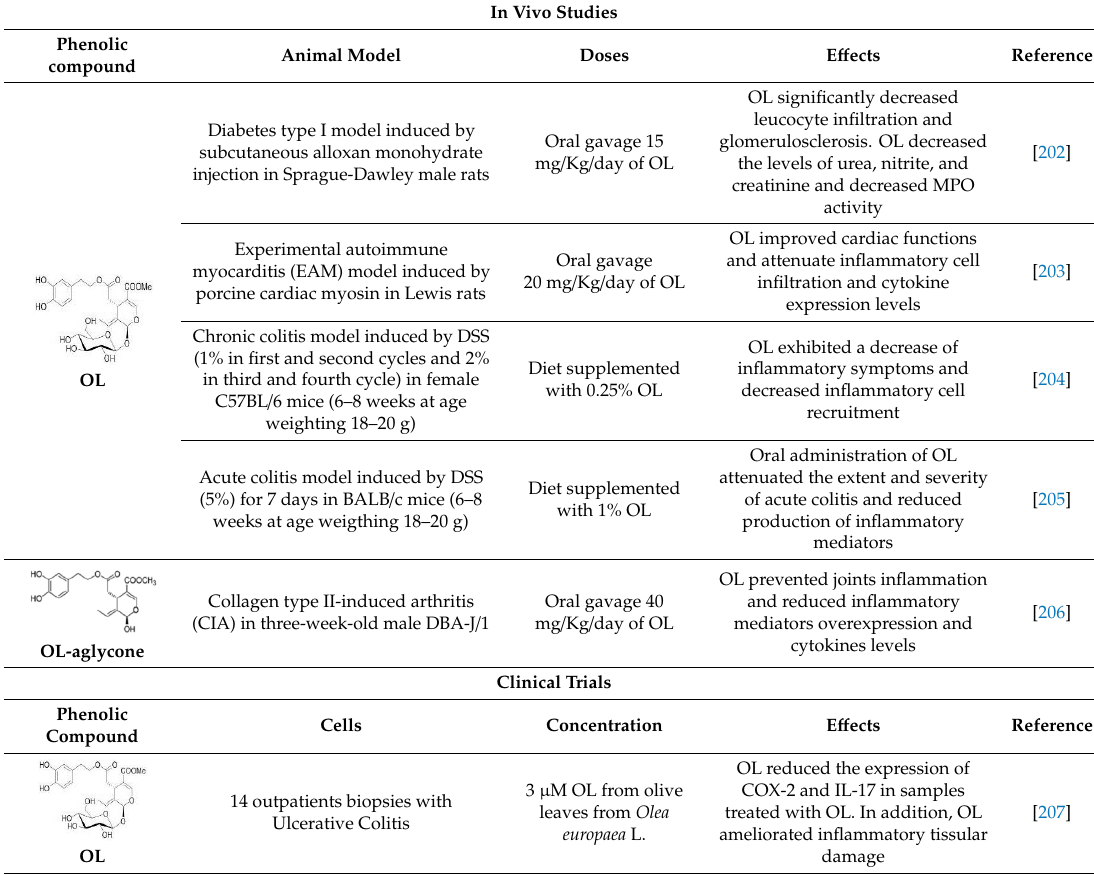
Table 10. E ff ective mechanisms and concentrations of bioactive secoiridoids from the olive tree in Table 10. Effective mechanisms and concentrations of bioactive secoiridoids from the olive tree in in Table 10. Effective mechanisms and concentrations of bioactive secoiridoids from the olive tree in in vivo models and clinical trials of immunoinflammatory diseases. in vivo models and clinical trials of immunoinflammatory diseases. Table 10. Effective mechanisms and concentrations of bioactive secoiridoids from the olive tree in in vivo models and clinical trials of immunoinflammatory diseases. vivo models and clinical trials of immunoinflammatory diseases. In Vivo Studies